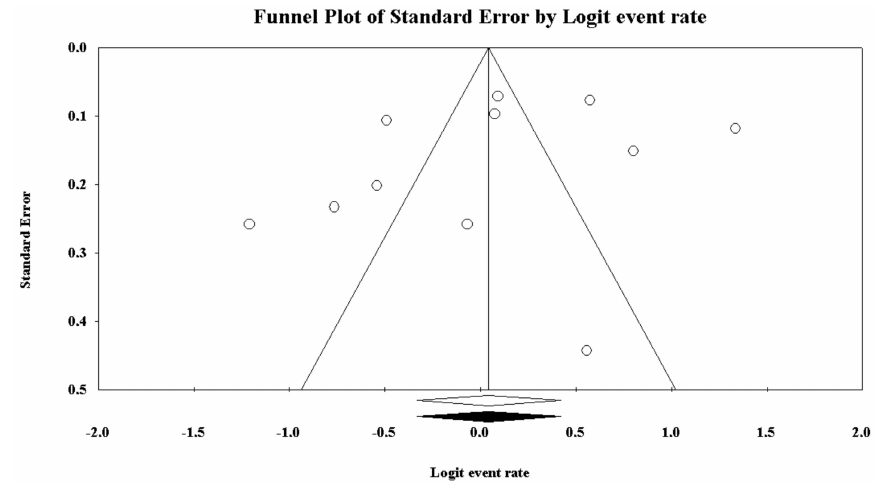
Figure 4. Funnel plot of the meta-analysis of the prevalence of low sleep quality in police officers.